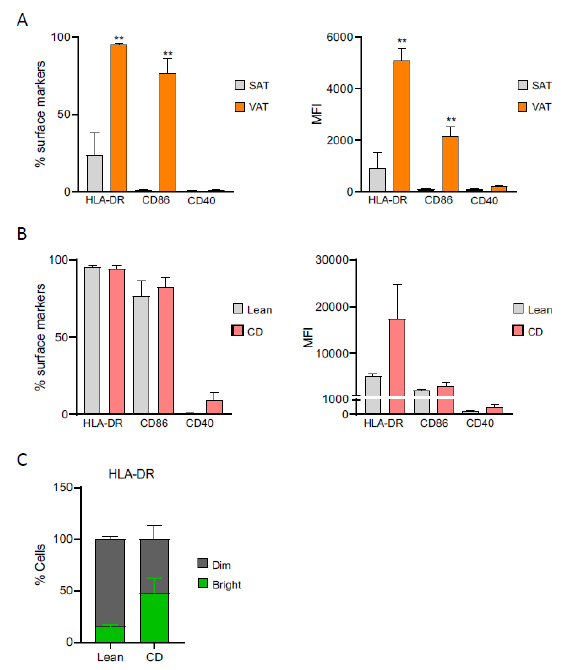
Figure 5. Creeping fat-derived ASCs have an altered immunophenotypic profile with respect to their lean counterparts. ASCs were stained with the panel of antibodies described and analyzed by flow cytometry using a FACSAria III (BD Biosciences, Franklin Lakes, NJ, USA) equipped with three lasers operating at 405, 488, and 633 nm. Surface markers were detected using phycoerythrin (PE) (585 nm band-pass filter), PE-Cy7 (780 nm band-pass filter), allophycocyanin (APC) (660 nm band-pass filter), Fluorescein isothiocyanate (FITC) (530 nm band-pass filter), Peridinin-Chloro- phyll-Protein (PerCP-cy5.5) (695 nm band-pass filter), and BD Horizon Brilliant Violet 421 chan- nels (450 band-pass filter). Gating was based on forward-scatter and side-scatter dot plots. A side- scatter versus Ho342 dot plot was used to discriminate nucleated cells from debris. Analysis of antigen-presenting molecules compared the ( A ) percentage of surface expression and mean fluo- rescence intensity (MFI) between subcutaneous (SAT)-derived ASCs versus visceral (VAT)-de- rived ASCs from lean patient and the ( B ) percentage of surface expression and MFI between lean- derived ASCs versus Crohn’s disease -derived ASCs, from visceral and mesenteric adipose tissue, respectively. ( C) Percentage of HLA-DR subpopulations HLA-DR dim and HLA-DR bright in lean- derived and Crohn’s Disease - derived ASCs. Abbreviations: CD, Crohn’s disease; ob, obese; HLA- DR, human leucocyte antigen — DR isotype; VAT, visceral adipose tissue; SAT, subcutaneous adi- pose tissue. Data are expressed as the mean ± SEM; ** p < 0.01 (Mann-Whitney U test with Benja- min-Hochberg adjustment).